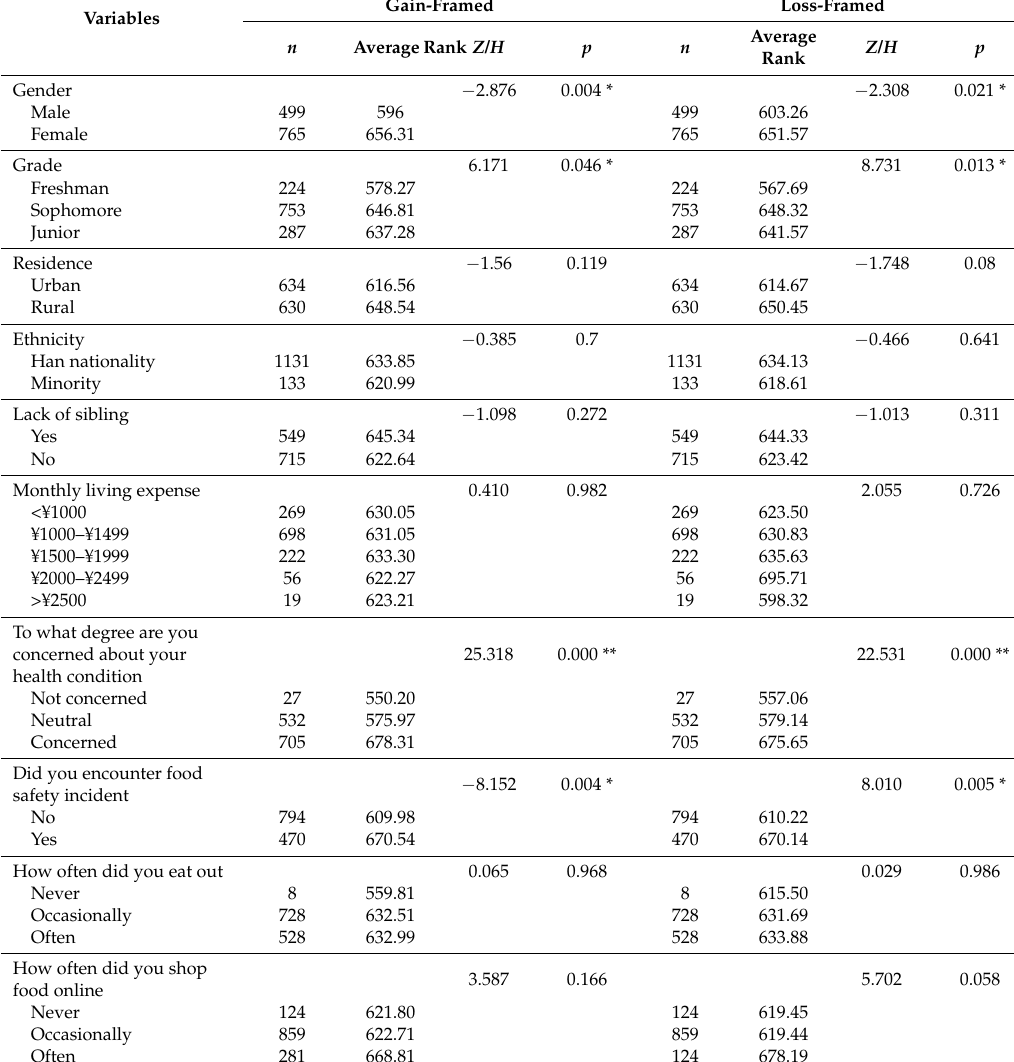
Table 5. Wilcoxon rank sum test/Kruskal–Wallis test for demographic characteristics and personal